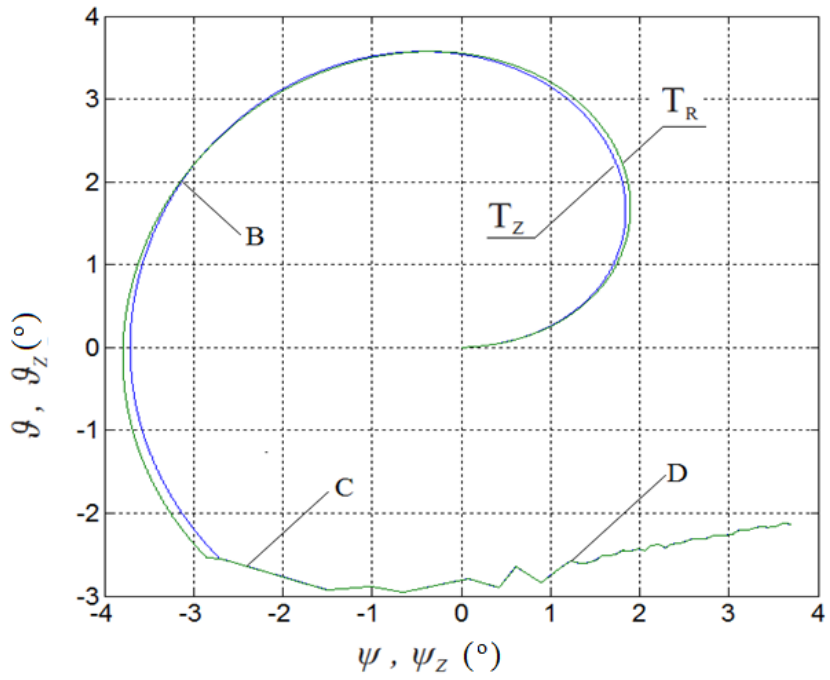
Figure 13. T Z set trajectory and pursued T R trajectory of the seeker axis in the airspace search phase and in the detected target tracking phase–PID control.